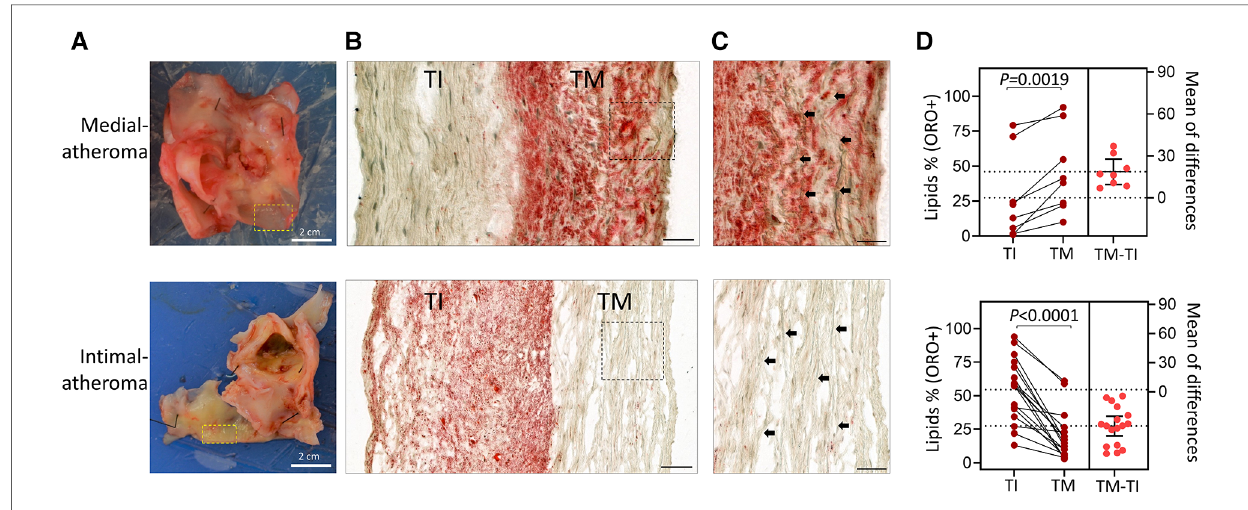
FIGURE 8 Identi fi cation of patients ’ post-CEA with elevated atheroma in the tunica media compared to the tunica intima. ( A ) Photographic images of arterial specimens obtained from patients post-CEA. Selected regions representing early-stage disease without plaques were compared for lipid content (ORO + ). (B) Micrographs show lipid deposition (ORO + ) in tunica media (TM) or tunica intima (TI) in the indicated groups. ( C ) Magni fi ed fi elds of view from ( B ) showing elastin fi bers (black arrows) in the tunica media. Scale bars in B , C : 100 µm. ( D ) Estimation plots showing percentages of atheroma based on ORO + staining in tunica intima (TI) compared to tunica media (TM). Data are shown for individual patients; n =8 patients with greater atheroma in TM than in TI and n =17 patients with atheroma higher in TI than in TM. (** p =0.0019 and **** p <0.0001 by paired Student ’ s t -test). The right panel graphs show the mean difference between the compared groups and the 95% con fi dence